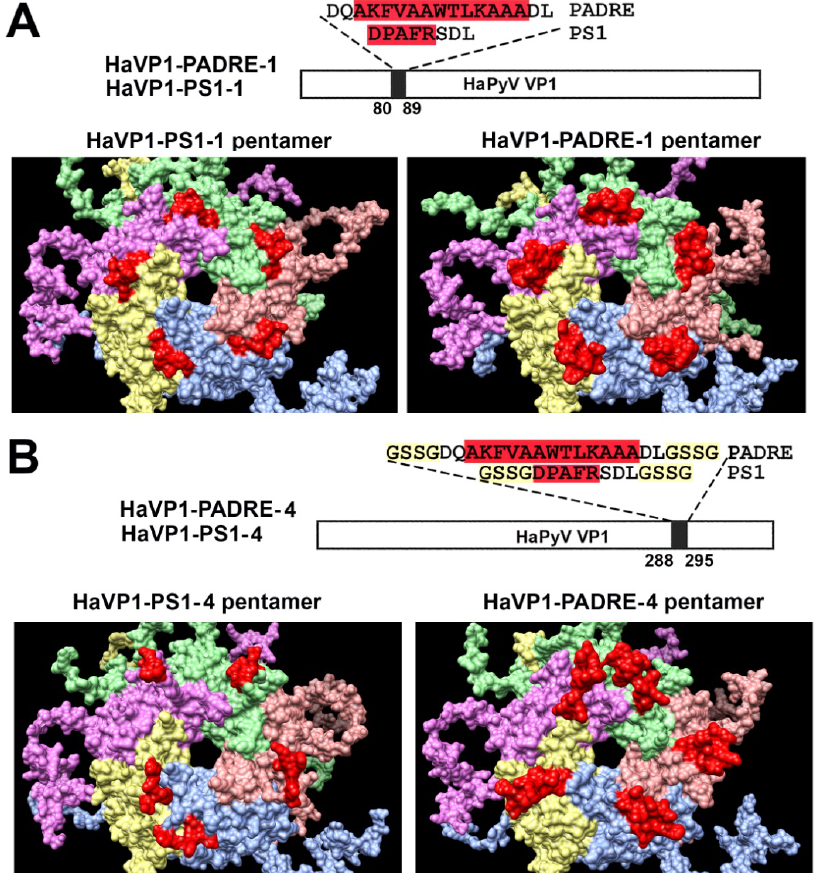
Figure 3. Molecular models of HaPyV VP1-derived chimeric proteins harboring either PS1 peptide (construct short name HaVP1-PS1) or PADRE peptide (construct short name HaVP1-PADRE) at site #1 (( A ) constructs HaVP1-PS1-1 and HaVP1-PADRE-1) or site #4 (( B ) constructs HaVP1-PS1-4 and HaVP1-PADRE-4). The inserts are shown in red.